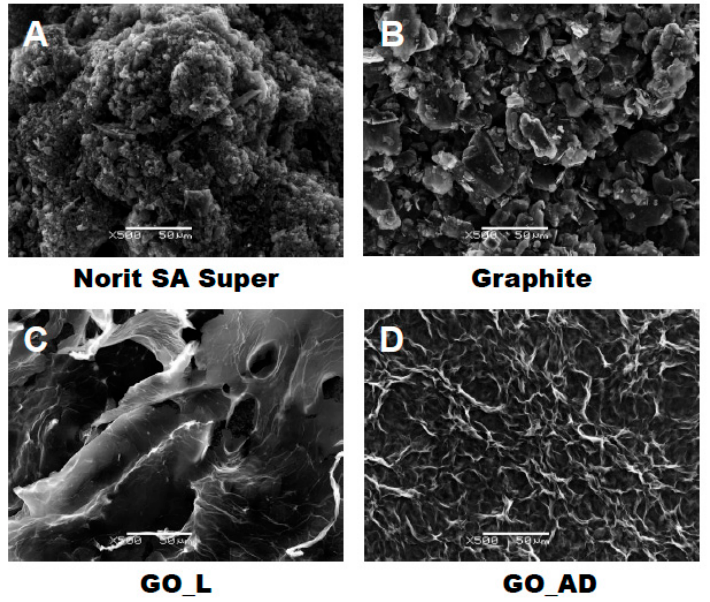
Figure 3. Scanning electron microscope (SEM) showing carbon materials used in laboratory tests: activated carbon Norit SA Super ( A ), graphite ( B ), graphene oxide after lyophilization—GO_L ( C ), graphene oxide after air drying—GO_AD ( D ).